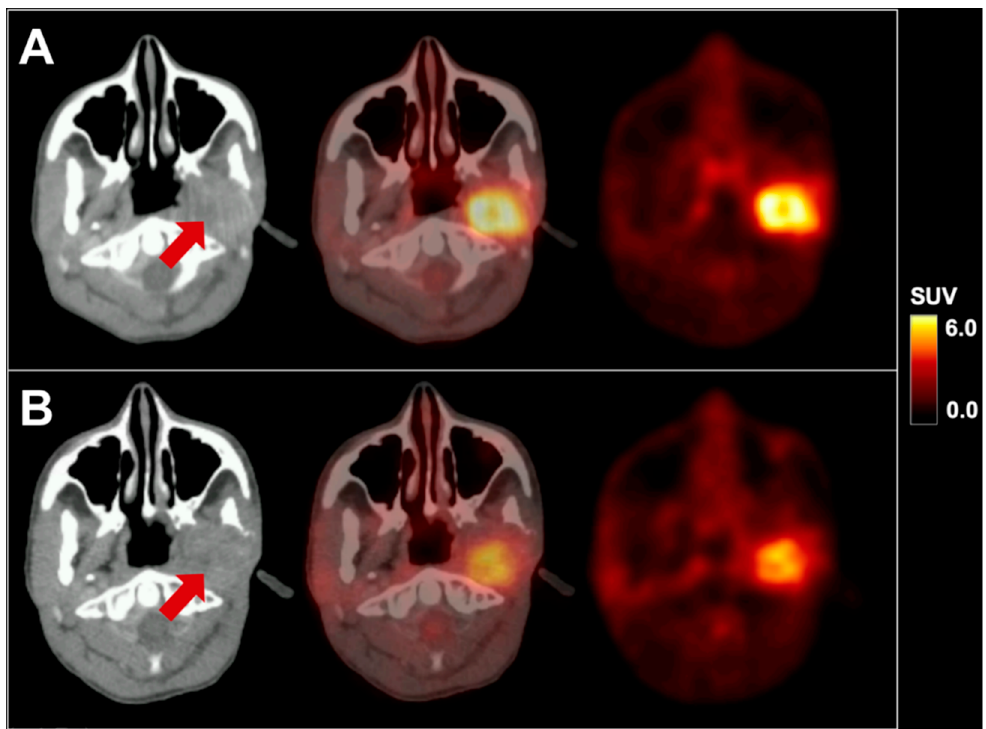
Figure 1. 18 F-FDG PET/CT in axial planes of a pediatric sebaceous carcinoma before ( A ) and after therapy ( B ). The red arrow indicates the primary site in the left parotid gland. SUV = standardized uptake value.